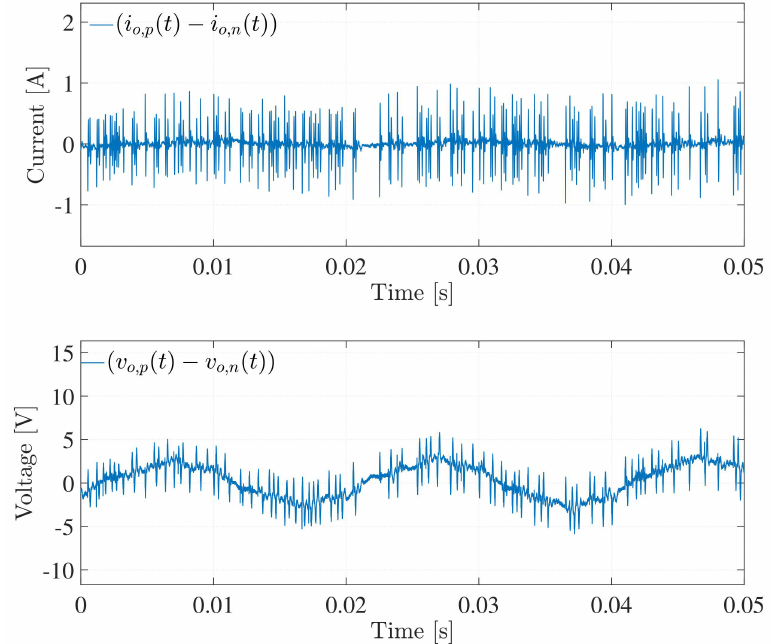
Figure 16. Small-signal perturbations of the current, ( i o , p ( t ) − i o , n ( t ) ), and the voltage, ( v o , p ( t ) − v o , n ( t ) ), after PRIS